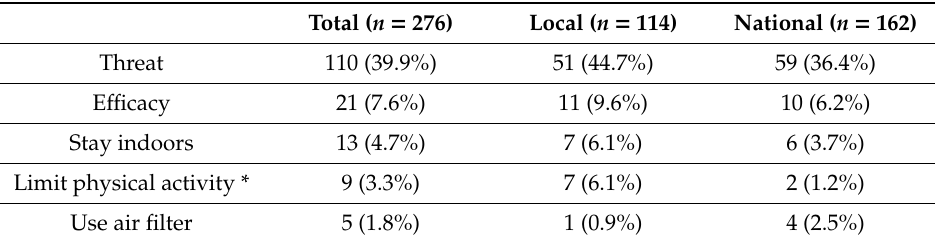
Table 1. Threat and e ffi cacy information in news coverage of air pollution.